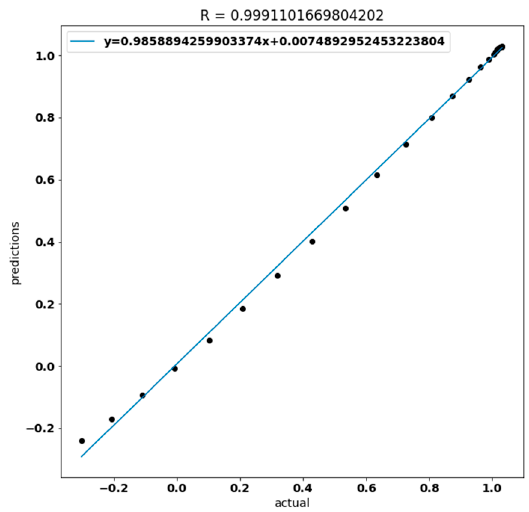
Figure 19. Taylor Diagram showing the standard deviation, correlation, and RMSE of the proposed model and the reference model.